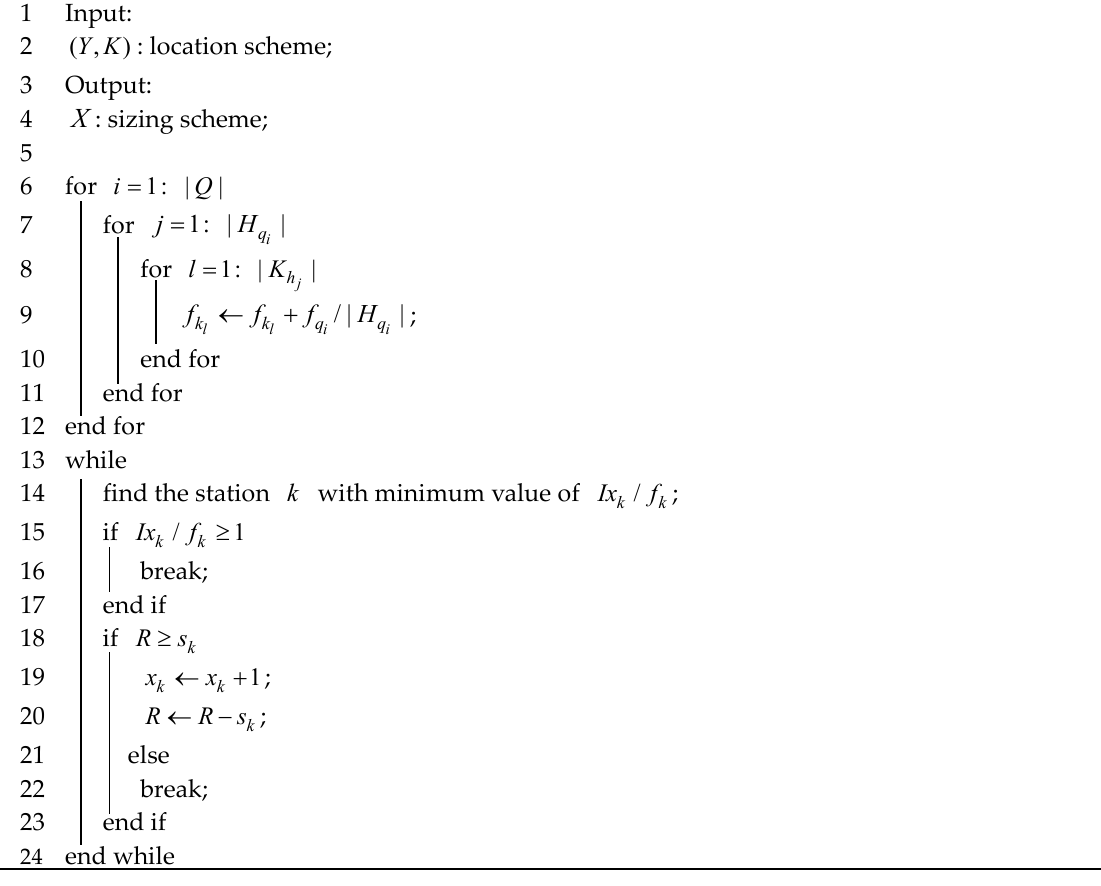
Algorithm 1. The pseudo-code of initial sizing scheme setting.